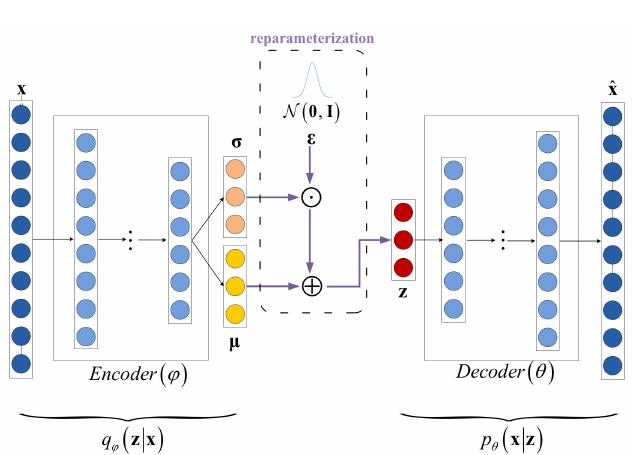
Figure 3. Architecture of the VAE with Gaussian distribution